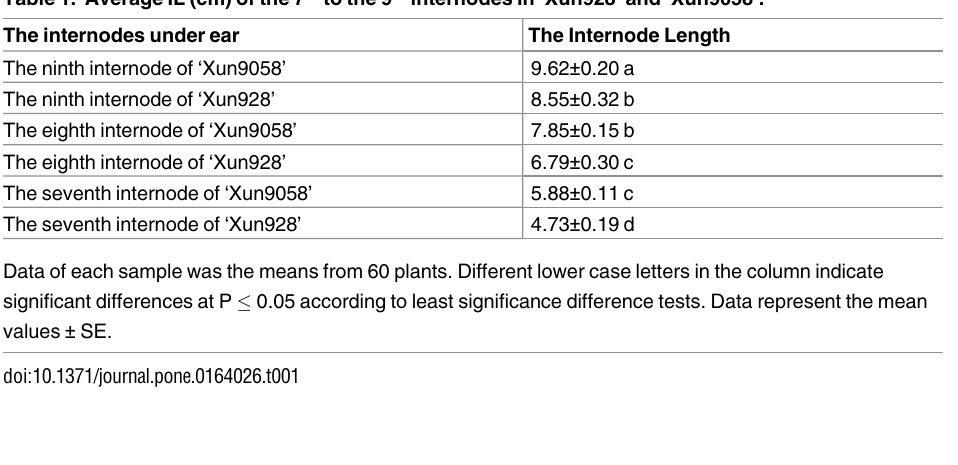
Table 1. AverageIL (cm) of the 7 th to the 9 th internodes in ‘Xun928’ and ‘Xun9058’. The internodes under ear The Internode Length The ninth internode of ‘Xun9058’